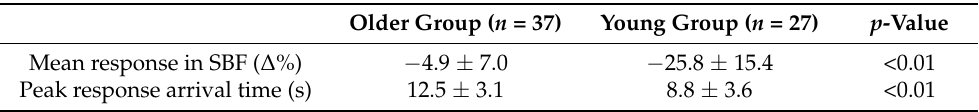
Figure 2. Time course of mean changes ( ∆ ) in skin blood flow in the finger (SBF) before, during, and after Braille reading in young (open circles) and older (solid circles) subjects. The duration of plate touching is shown by the horizontal bar. Values are shown as the mean ± standard error of the mean—percent changes from baseline levels. Significant difference between the two age groups: * p < 0.01. Table 1. Comparison of the mean change and peak response arrival time in SBF to Braille reading between age groups.